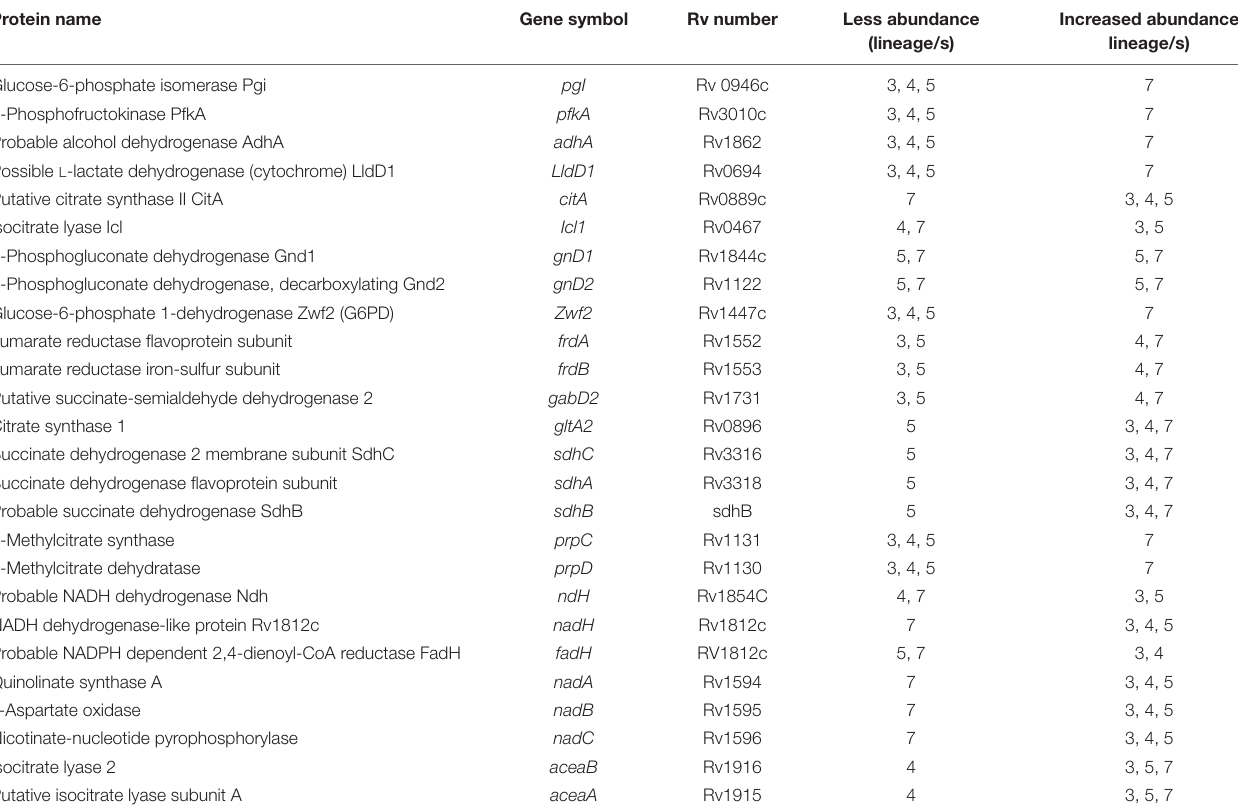
TABLE 5 | Differentially abundant proteins involved in energy metabolism in MTBC lineages.